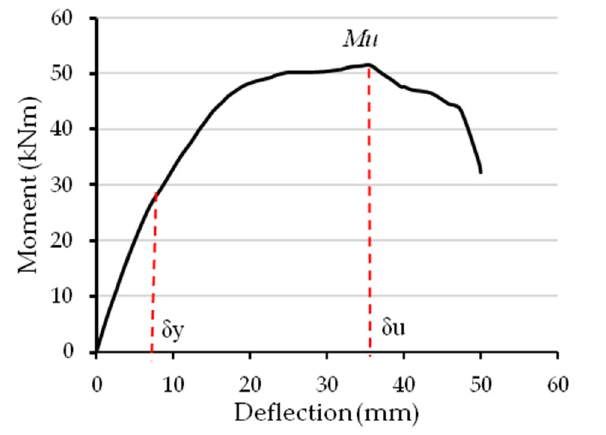
Figure 15. Typical moment–deflection curve for estimating the DI.